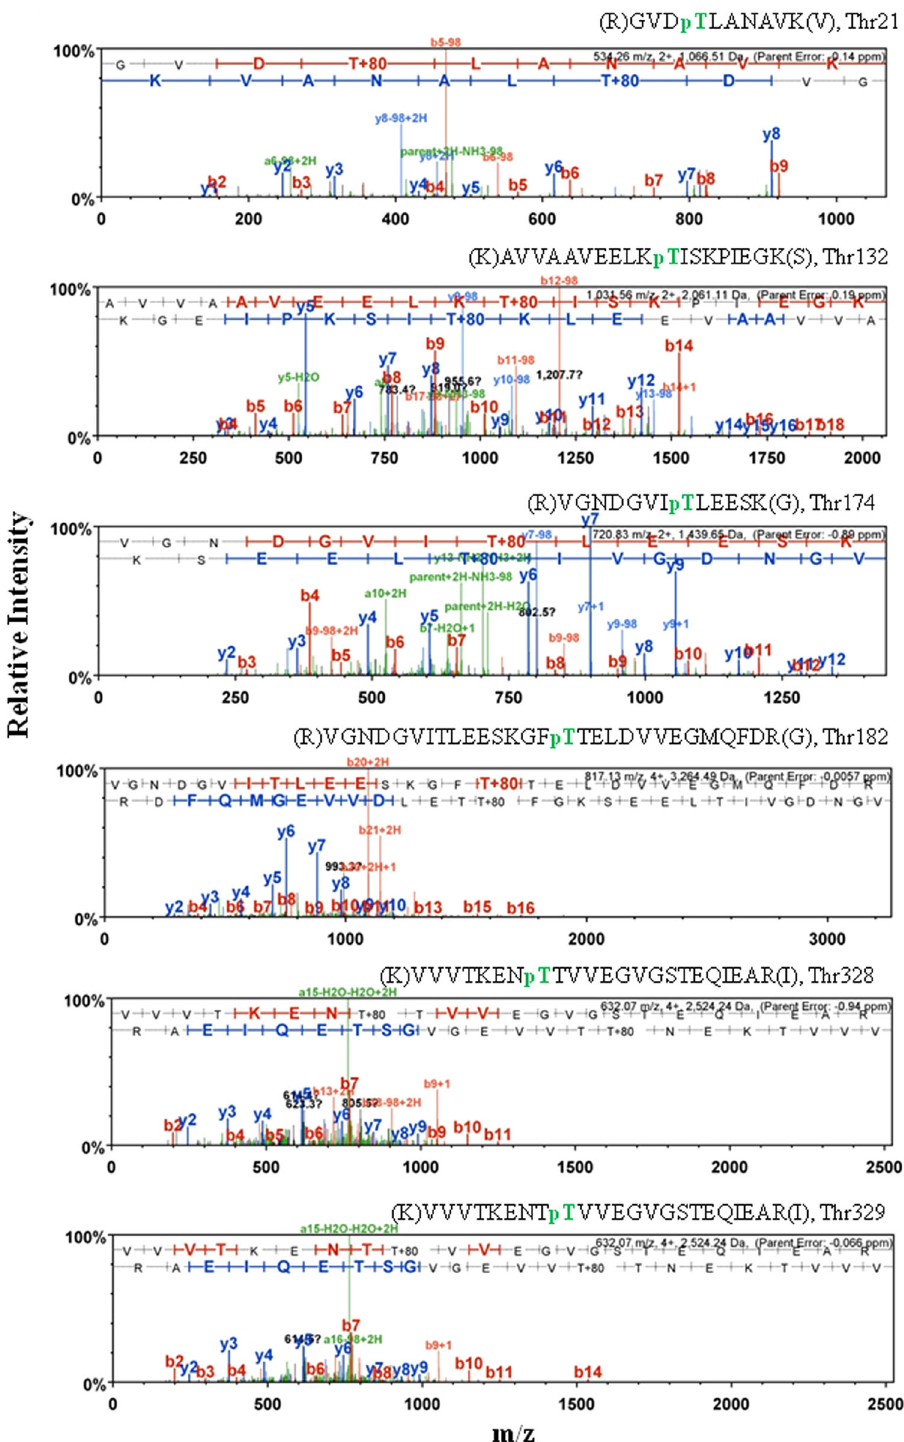
Fig. 5 Phosphorylation sites of GroEL: mass spectrometry spectra showing the phosphorylation sites of GroEL. The spectra were displayed using the Scaffold software and corresponding trypsinized peptides are shown. Phosphorylated threonine residues within the identi fi ed peptides are marked in